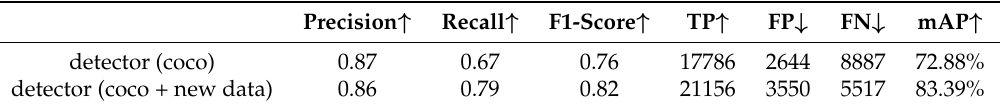
Table 1. Detection performance of detector trained with different